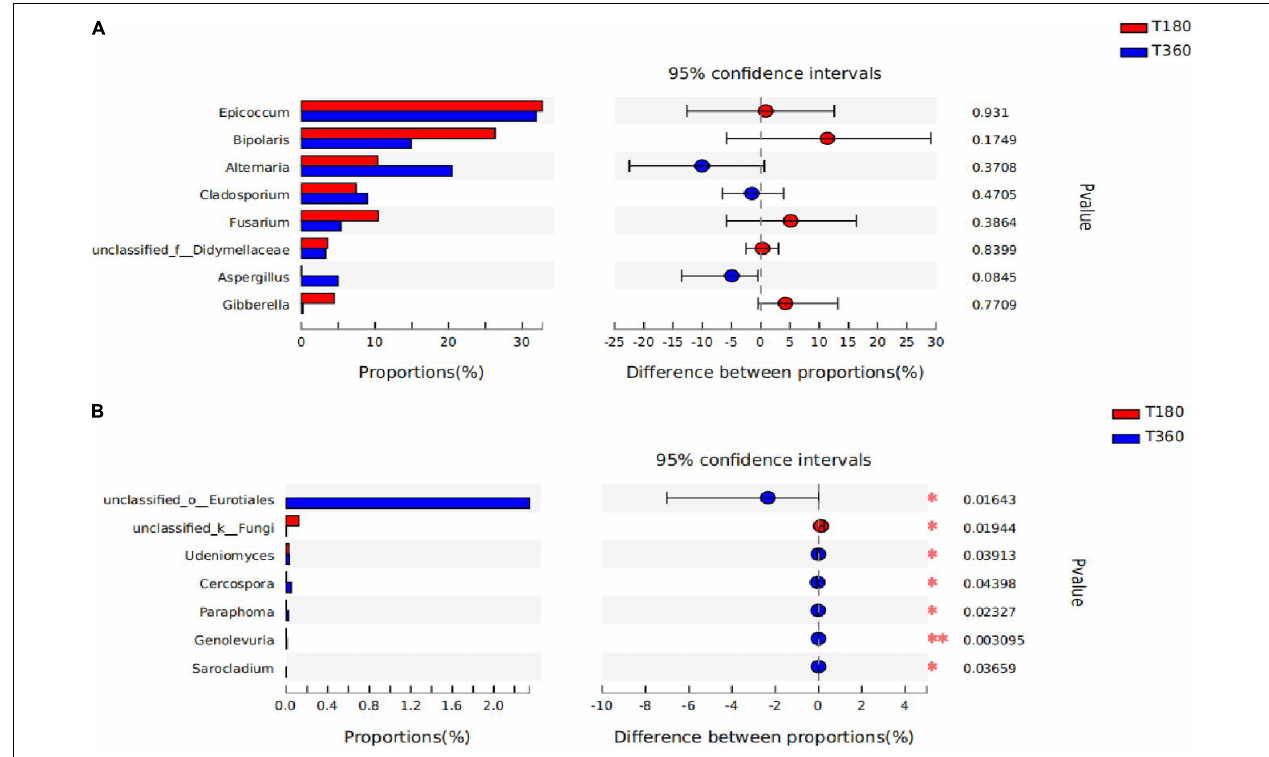
FIGURE 9 | The difference between the two groups of dominant genera (A) and the genera are significantly different between the two groups (B) . The bar length of each genus represents the proportion of the genus in the sample (red: 180 days of storage; blue: 360 days of